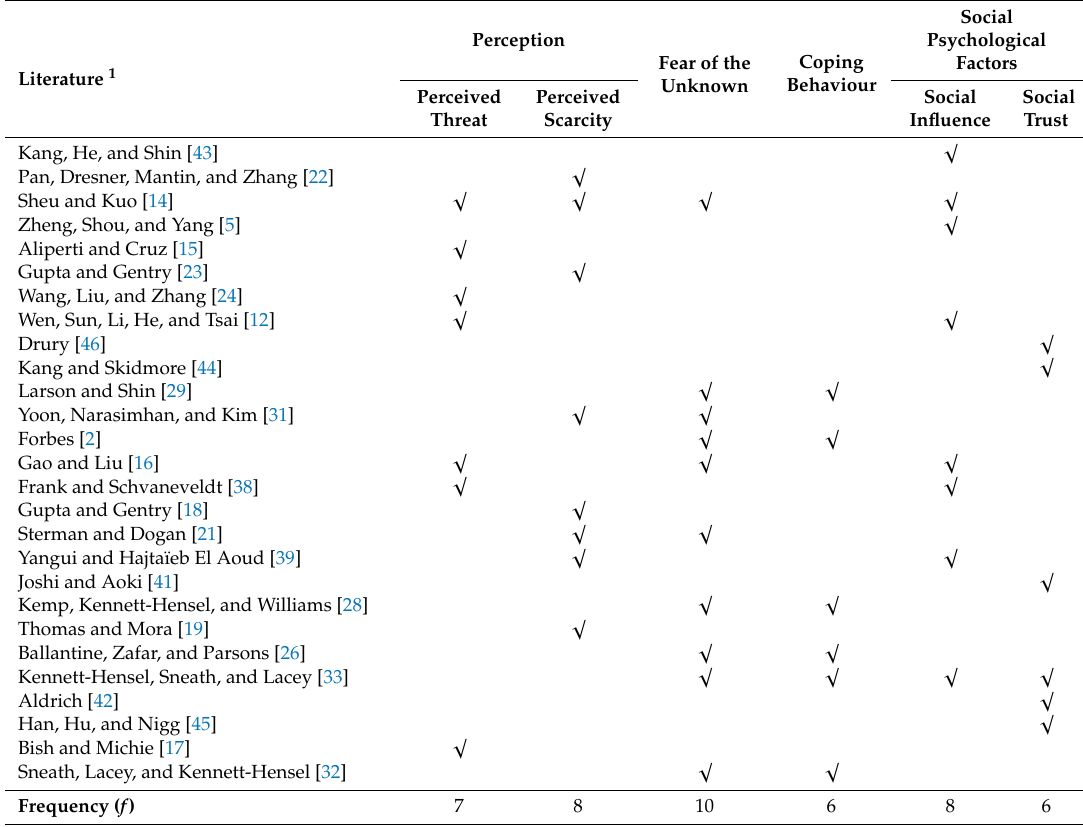
Table A1. Themes of reviewed